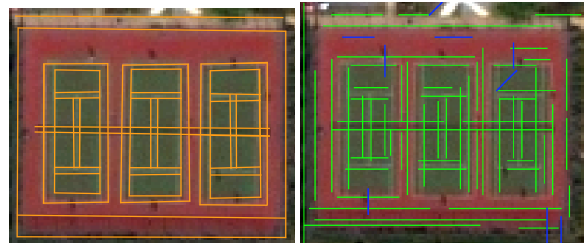
Figure 10. Ground truth image and detected Edges of tennis court used in evaluation